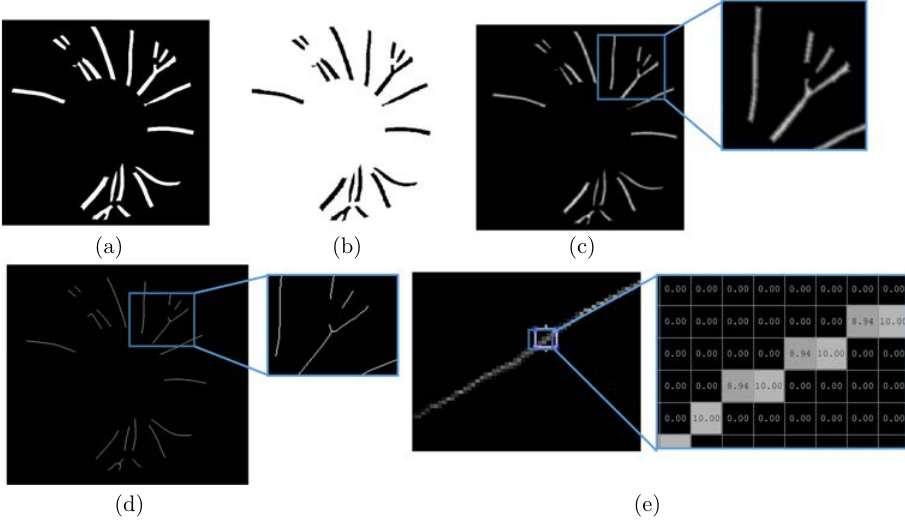
Fig. 12. Vessel width computation. (a) Binary vessel map, (b) Complement of binary vessel map, (c) Distance map of complement binary map, (d) Center-line vessels and (e) Product of (c) and